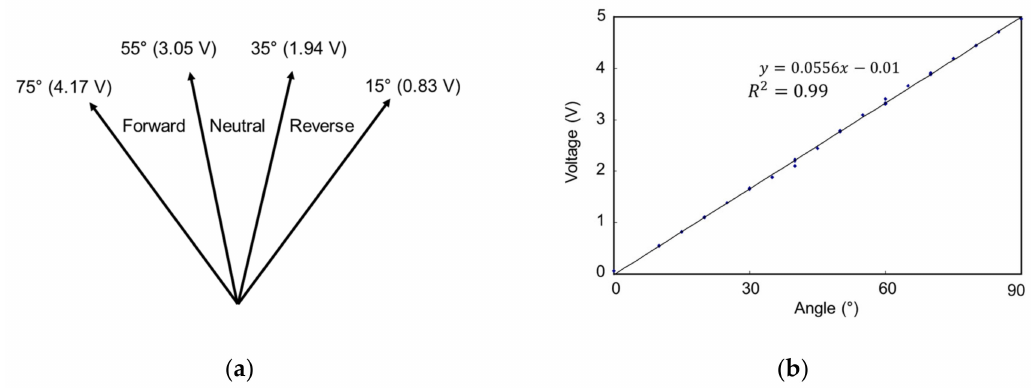
Figure 5. ( a ) Potentiometer values; and ( b ) calibration result, according to position of clutch